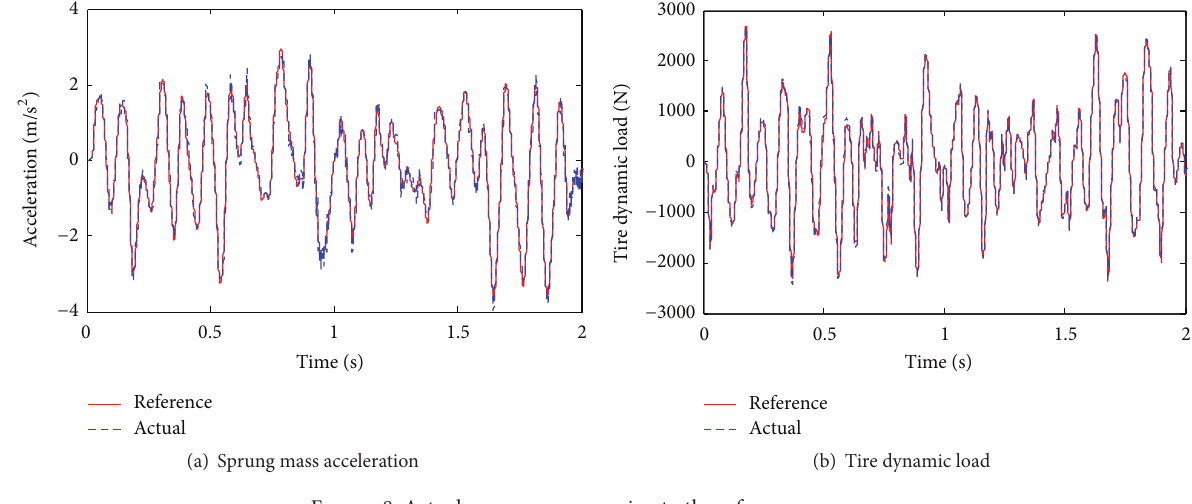
Figure 8: Actual responses comparing to the reference responses. Table 7: RMS values of hybrid suspension for the three